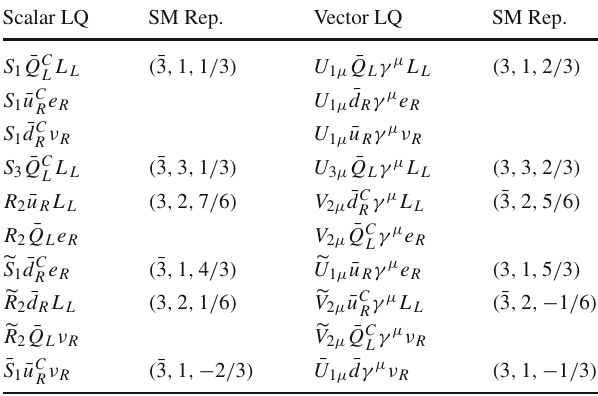
Table 1 Possible couplings of the scalar and vector LQs to the SM fermions and the right-handed neutrinos ν R , as well as their representa- tionsundertheSMgaugegroupSU(3) c ⊗ SU ( 2 ) L ⊗ U ( 1 ) α .Theinterac- tions between LQs and fermions are indicated only schematically and, for simplicity, their coupling constants and the Hermitian conjugated terms are not shown explicitly—they could be found, e.g., in Ref. [95]. Our convention for the hypercharge α is specified by Q em = T 3 + α , and the charge conjugate of a fermion field ψ is defined as ψ C = C ¯ ψ T , with C the charge conjugate